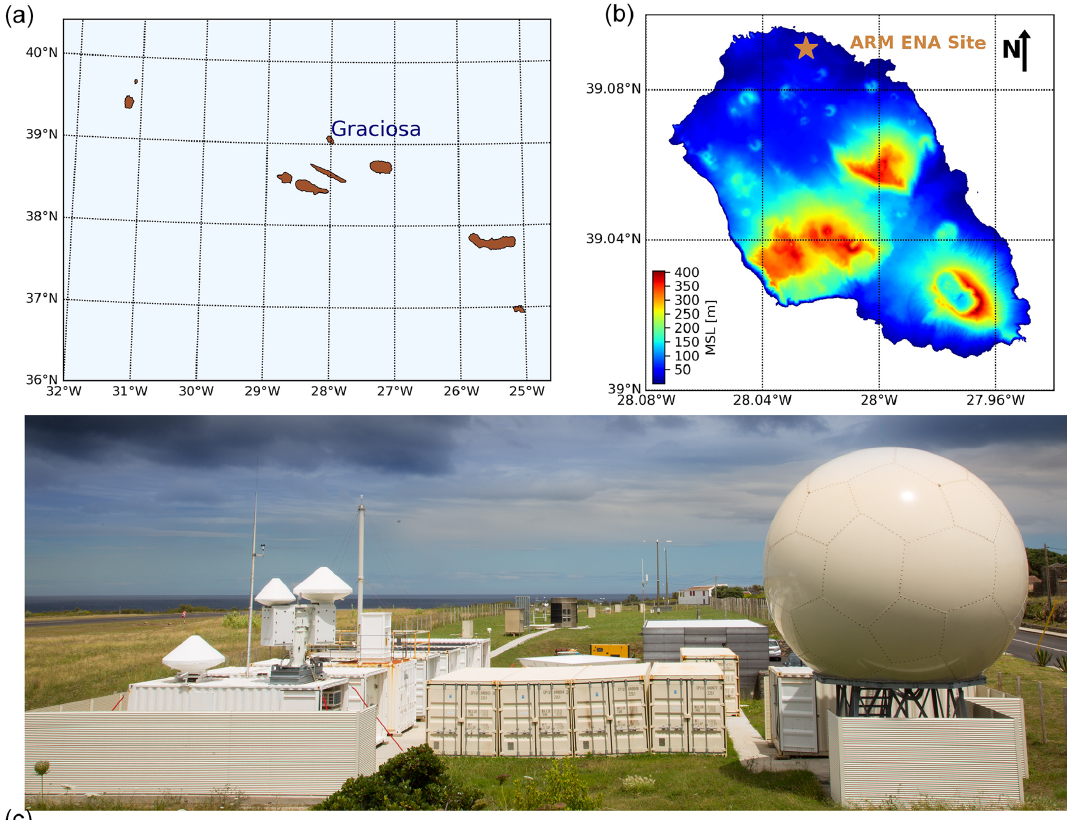
Figure 1. (a) Map showing the location of the Azores and Graciosa Island, (b) elevation map of Graciosa Island showing the location of the ARM ENA site on the northern coastline, and (c) photo of the ARM ENA site courtesy of the U.S. Department of Energy ARM user